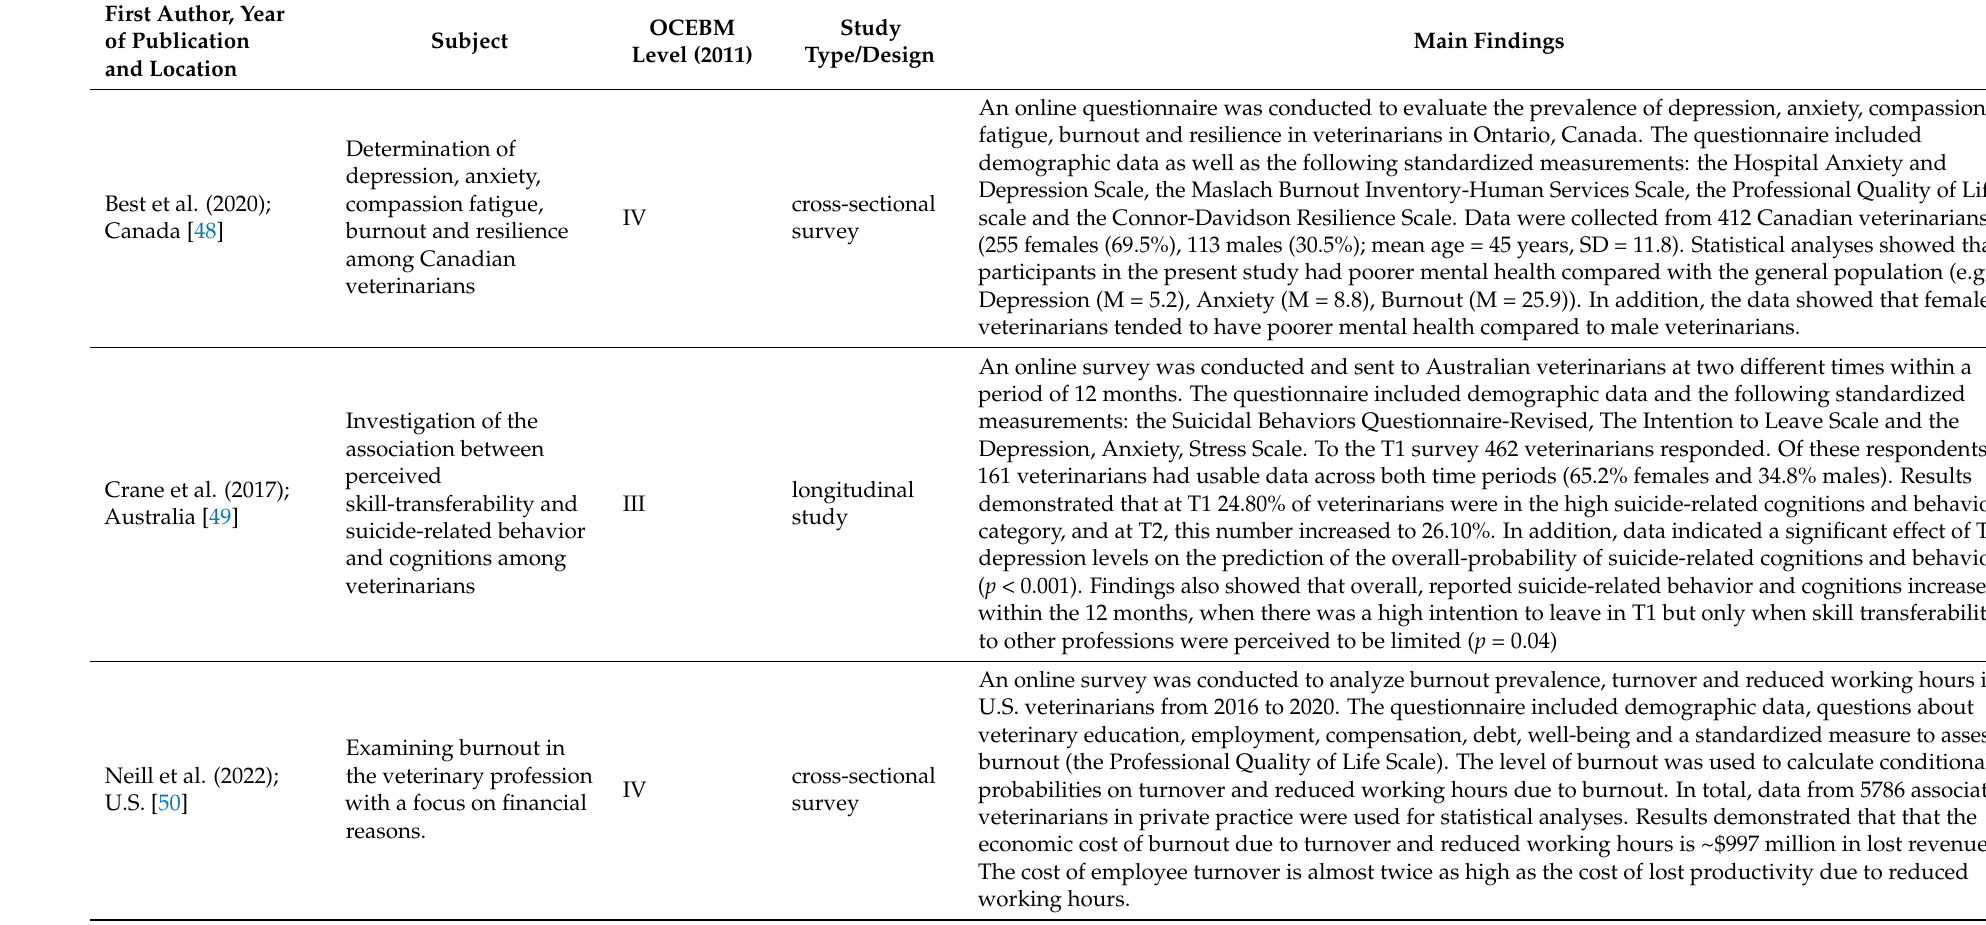
Table 4. Psychological